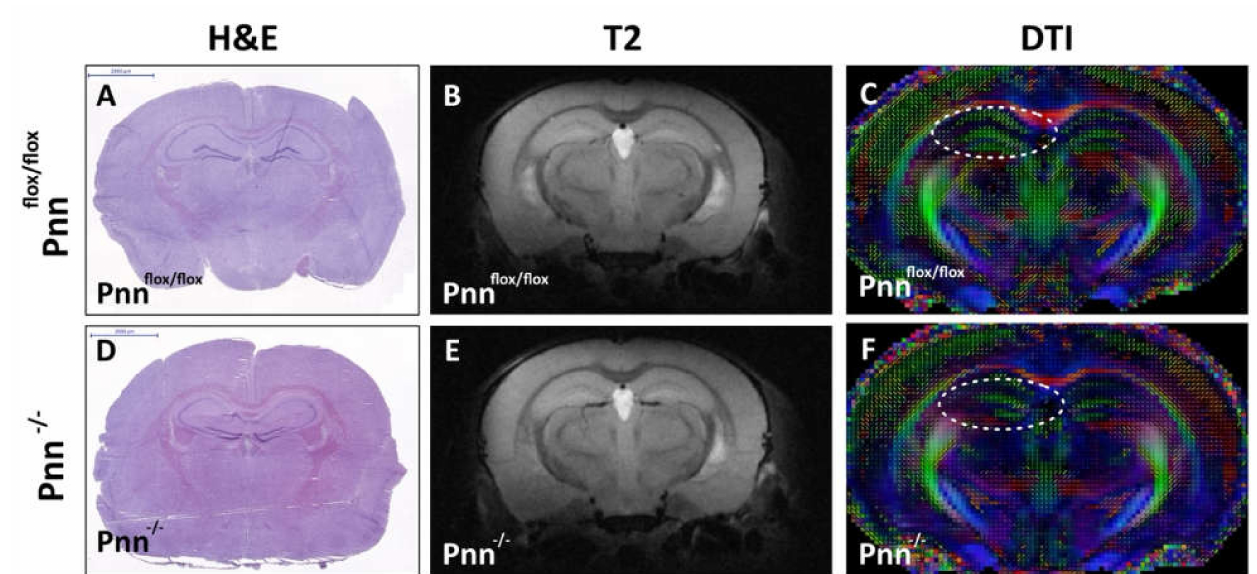
Figure 2. Cerebral histological and MRI examination on mice with neuronal Pnn depletion. ( A , D ) Hematoxylin and eosin staining on cerebral cryosections. ( B , E ) Magnetic resonance image analy- sis on 10-week-old male mice with or without neuronal Pnn depletion. ( C , F ) Diffusion tensor image to examine white matter tractography in 10-week-old mice with or without neuronal Pnn depletion. Although no significant structural difference was observed, the white matter tractography in hippocam- pus (white circle in ( C , F )) was altered by neuronal loss of Pnn. f/f, flox/flox mice. -/-, mice with homozygous neuronal Pnn deficiency. Scale bar indicates 2000 µ